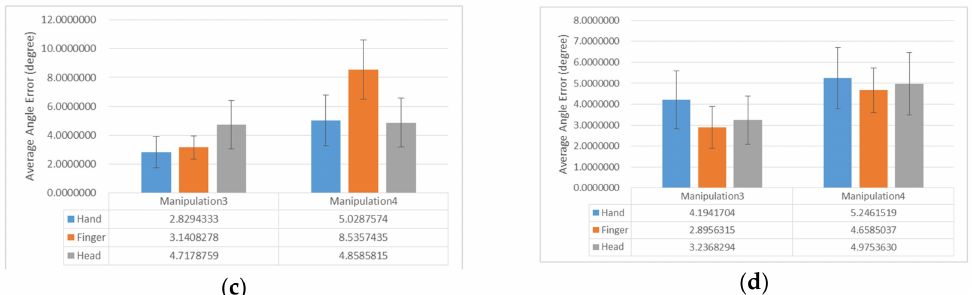
Figure 8. Angle error graph ( +/ - standard deviation of the average). The mean of the ( a ) angle error for each interaction, ( b ) x -axis angle error for each interaction, ( c ) y -axis angle error for each interaction, and ( d ) z -axis angle error for each interaction.